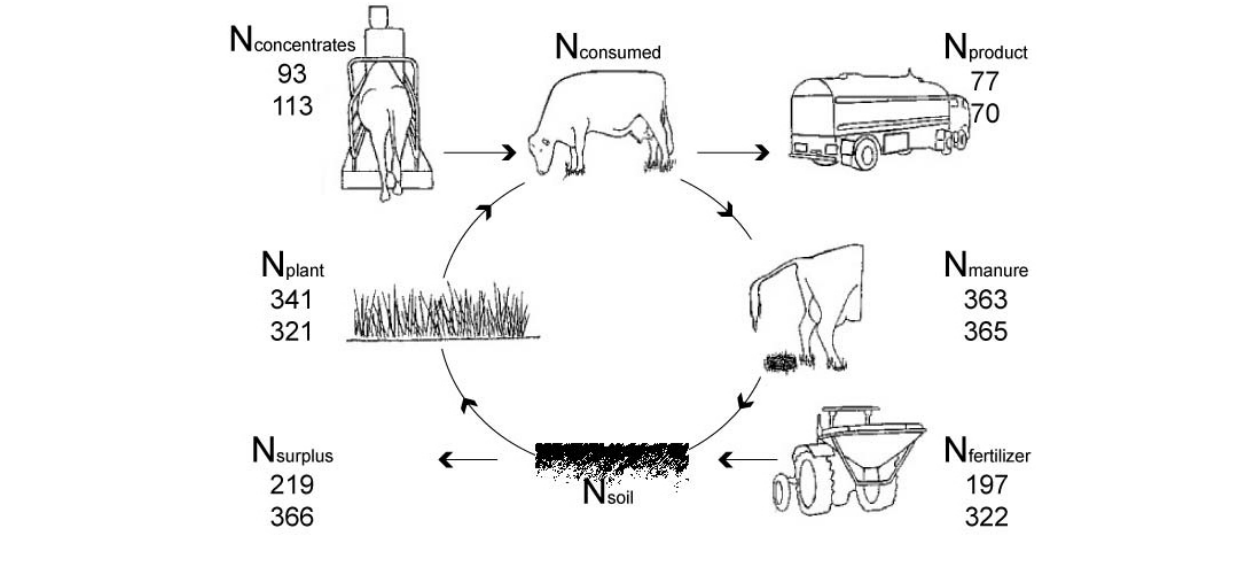
Fig. 1. The N cycle at a dairy farm, the numbers are N flows (kg/ha). The upper numbers are averages of farmers applying the reinforcing measures, the lower numbers are averages of conventional farmers in the area. Data are based on group averages in 1997 (Groot et al. 2006) and 17.8% and 16.1% efficiency of the